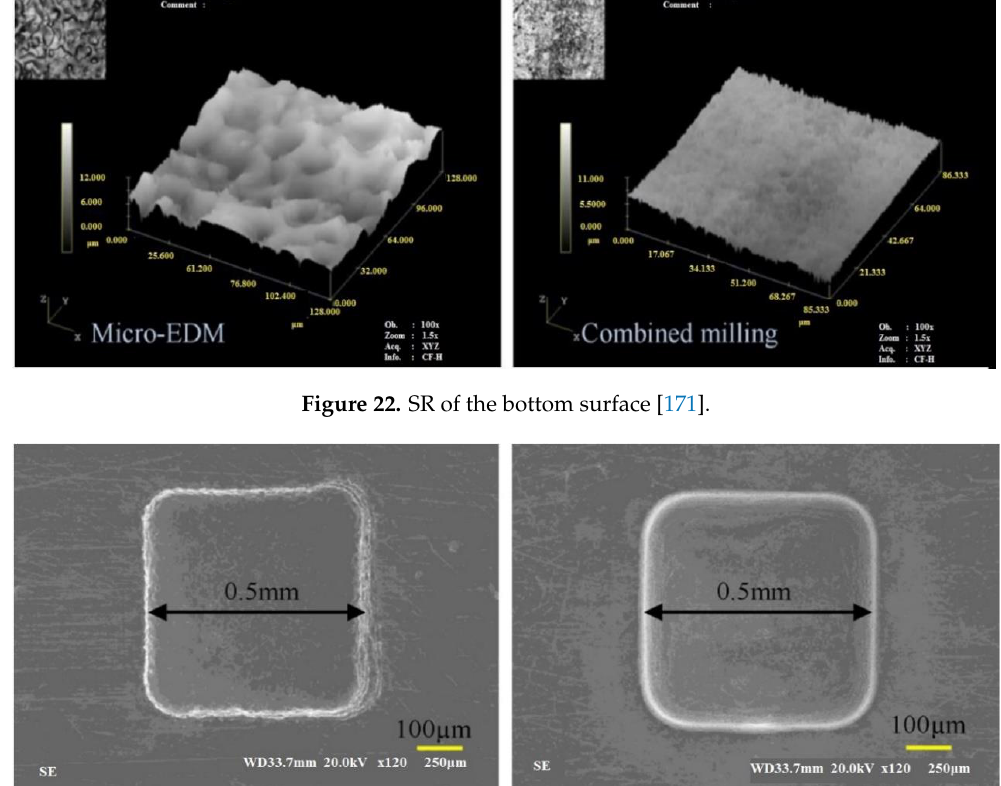
Figure 23. Scanning electron microscope (SEM) photos of the square cavity machined by EDM and micro-EDM combined with milling [171].